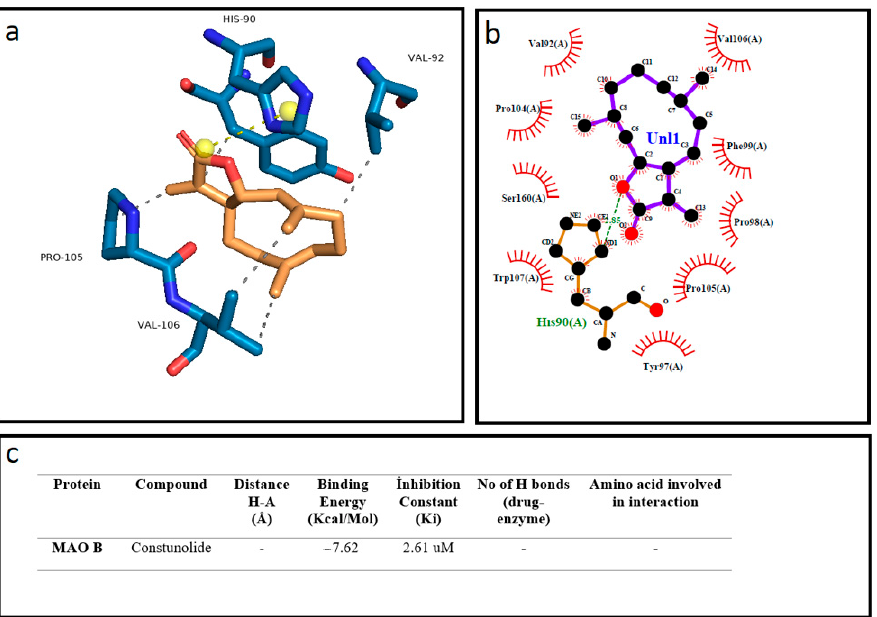
Figure 3. The best docking formation of the binding mode of Human Monoamine Oxidase B (Mao B-2BK5) with costunolide obtained by ( a )—PyMol, ( b )—LigPlot, and ( c )—the table of Hydrogen- bonds (H-bonds) (with distance Å), binding energy (Kcal/mol), inhibition constant, number of H-bonds (drug-enzyme) and amino acid involved in interaction obtained from the Protein-Ligand Interaction Profiler. The blue line and dashed gray show the H-bonds and Hydrophobic Interaction in Pymol, respectively.